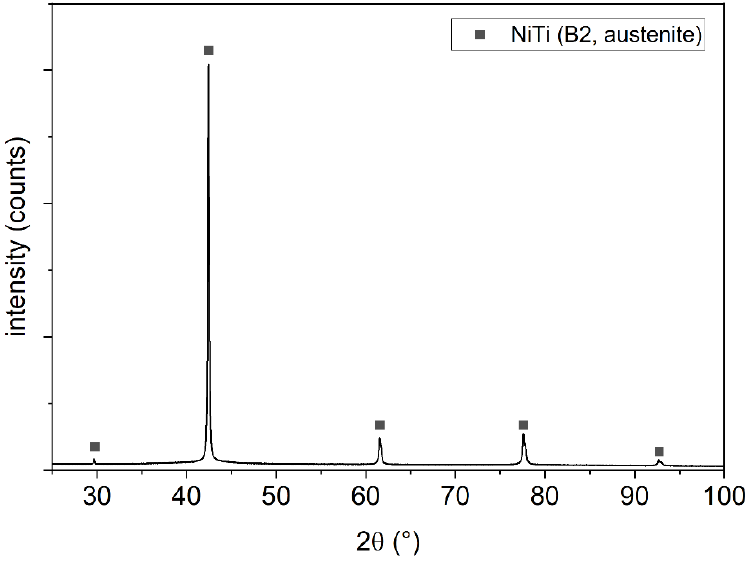
Figure 2. XRD of the initial powder showing only the austenitic B2 phase of NiTi.